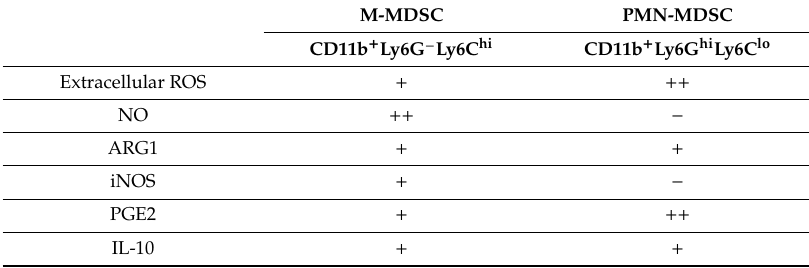
Figure 1. Di ff erentiation and accumulation of MDSCs in the TME. Chronic inflammatory factors, such as G-CSF and GM-CSF, are secreted to promote myelopoiesis. Instead of neutrophils and monocytes, MDSCs originate from common myeloid progenitor cells under pathological conditions and migrate through the circulatory system to the tumor site, in which MDSCs exert immunosuppressive functions by generating anti-inflammatory cytokines. TME, tumor microenvironment; HPC, hemopoietic progenitor cell; CMP, common myeloid progenitor; GMP, granulocyte-macrophage progenitor; MB, myeloblast; MDP, monocyte / macrophage and dendritic cell precursor; MDSC, myeloid-derived suppressor cell; TAM, tumor-associated macrophage; DC, dendritic cell; T reg , regulatory T cell; T e ff , e ff ector T cell; IL-10, interleukin-10; PGE2, prostaglandin E2; TGF β , transforming growth factor beta; IFN γ , interferon gamma; NO, nitric oxide; ROS, reactive oxygen species. Table 1. Common molecules and functions of MDSCs in